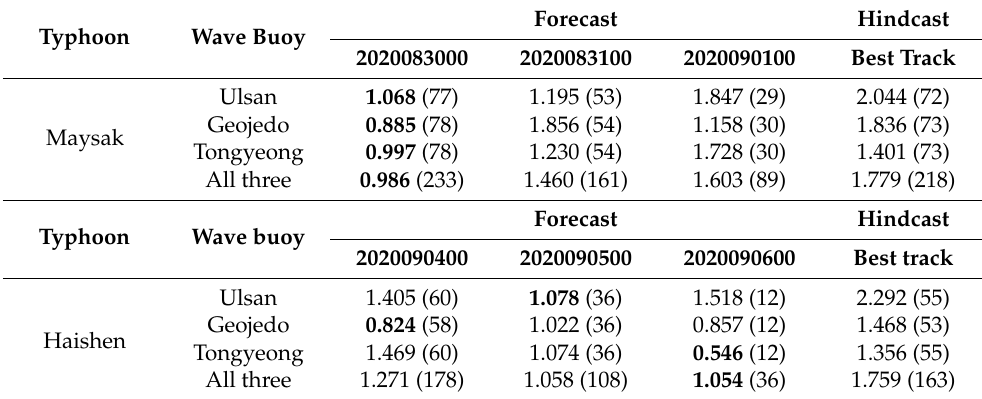
Table 3. Root mean square error (m) of significant wave heights from the MPAS forecast and the hindcast experiments for typhoons Maysak and Haishen. The number in parentheses indicates the number of samples. Here, better scores are indicated in